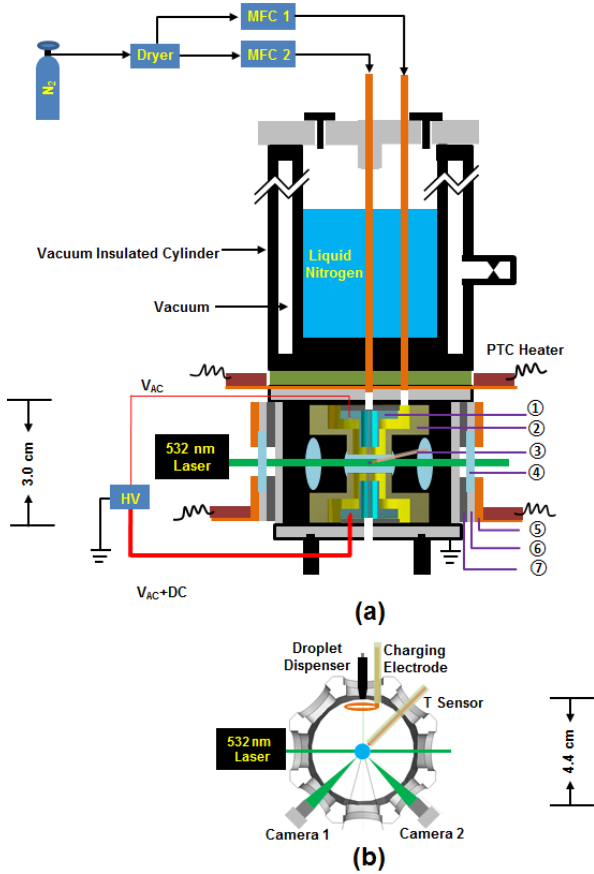
Figure 1. (a) Schematic diagram of the new CEDB system. (1) Inner electrode. (2) Outer electrode. (3) Thermocouple or relative humidity sensor. (4) Glass window. (5) Heating jacket. (6) Holder for glass window. (7) Rubber insulator. (b) The top view of the schematic diagram of optical design, dispensing and charging de- vices, and the thermocouple within the CEDB system. Cameras 1 and 2 are for droplet positioning and Mie scattering observation,